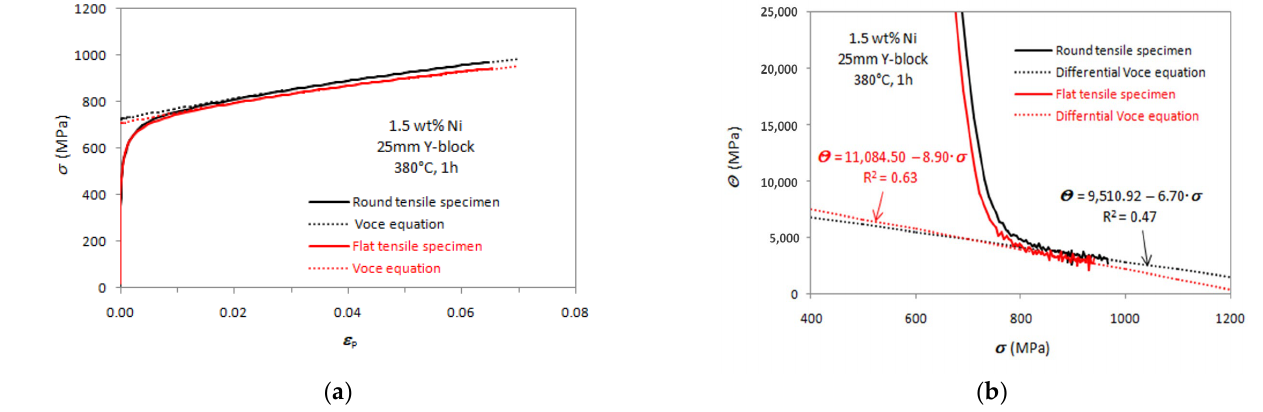
Figure 21. Comparison between tensile plastic behavior from round and flat tensile specimens: ( a ) tensile flow curves with round and flat tensile specimen of 1.5wt% Ni ADI from 25 mm Y-block austempered at 380 °C for 1 h; ( b ) differential data from the flow curves in ( a ) and strain hardening analysis based on differential Voce equation.